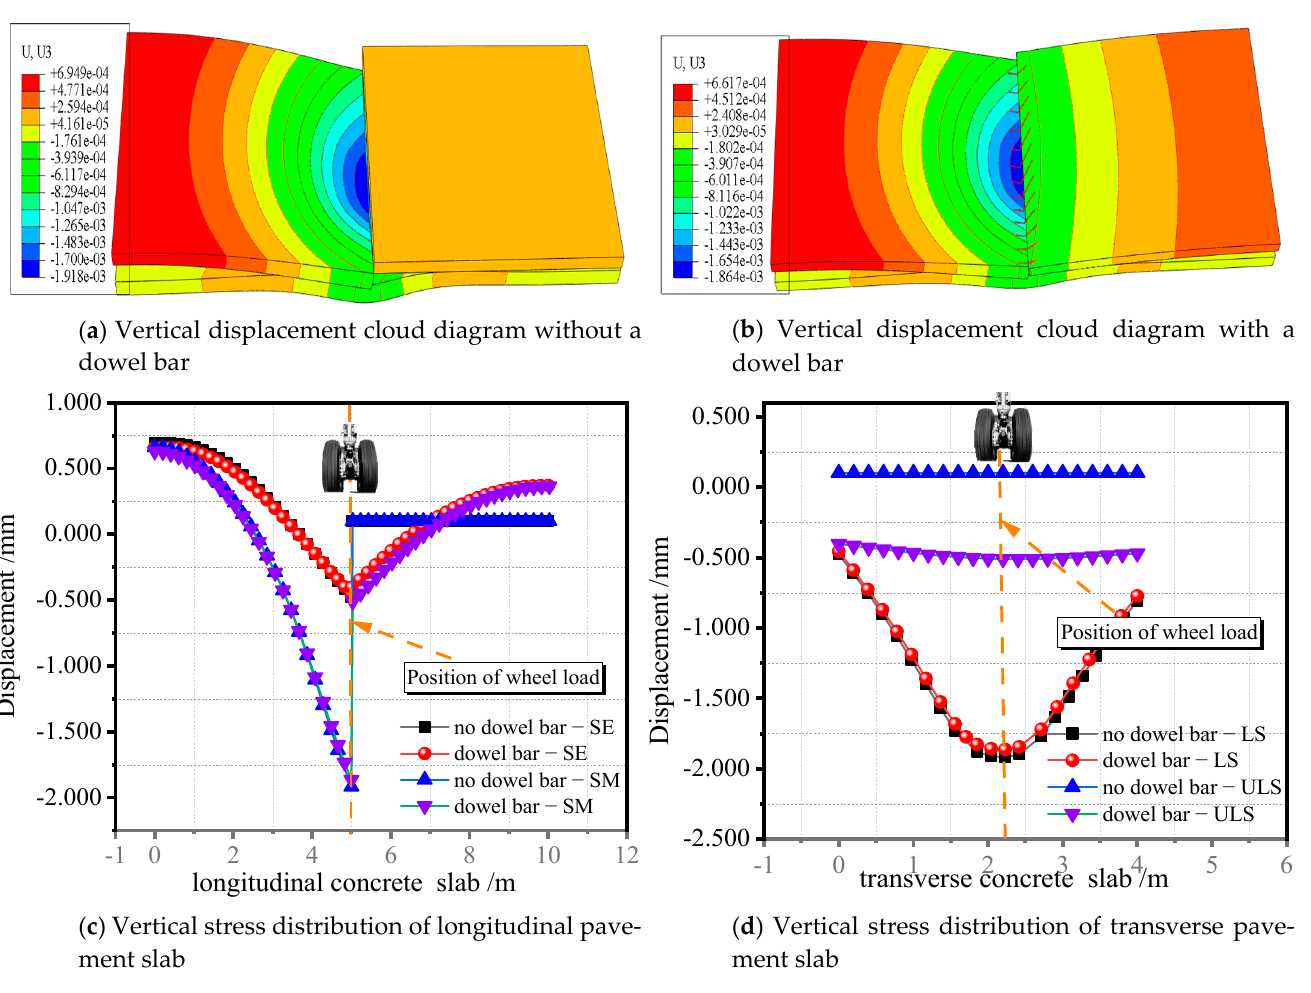
Figure 9. Vertical displacement distribution of the aircraft’s wheel load acting on the edge of adjacent slabs.